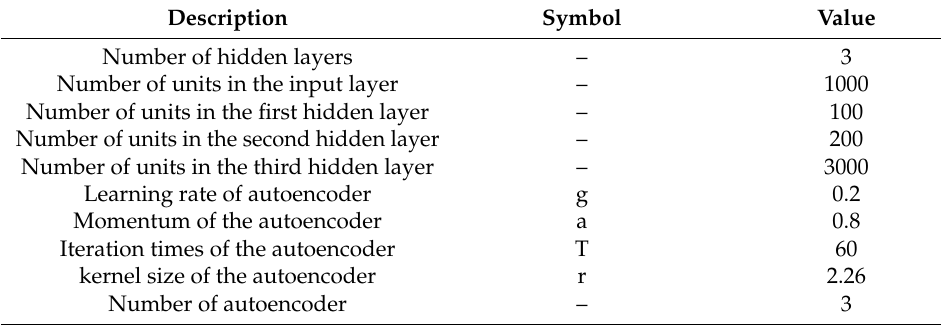
Table 1. Parameter used in the proposed framework.